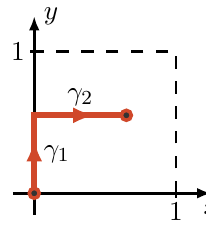
Figure 2 . Integration path γ := γ 1 γ 2 connecting the base point of integration { 0 , 0 } and a general kinematical point { x, y } inside the unit square.